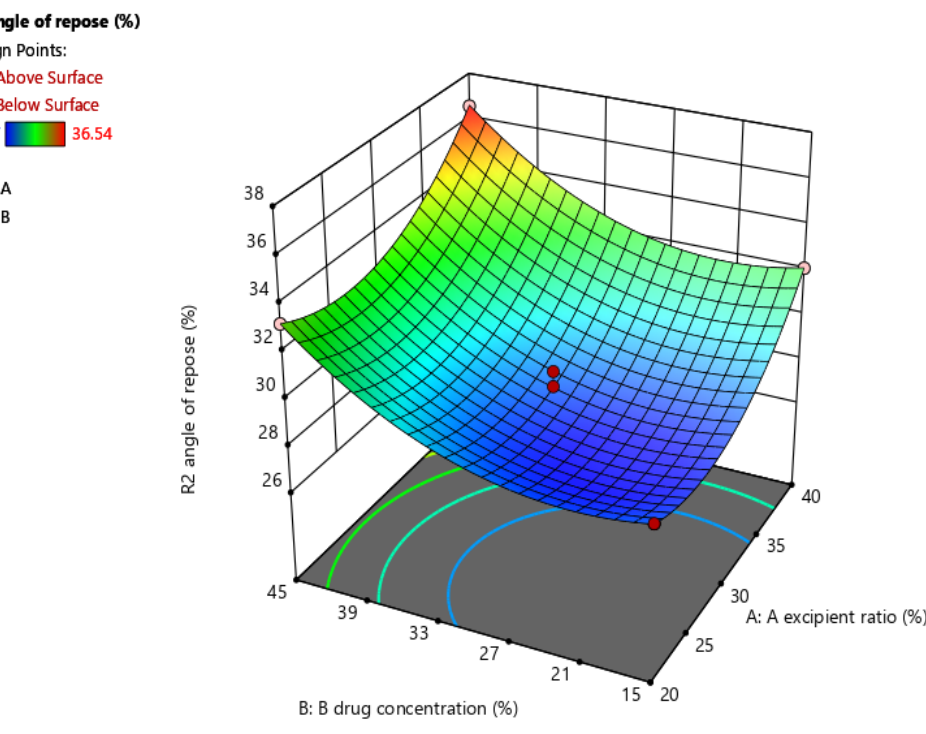
Figure 1. Surface response graph of the angle of repose.